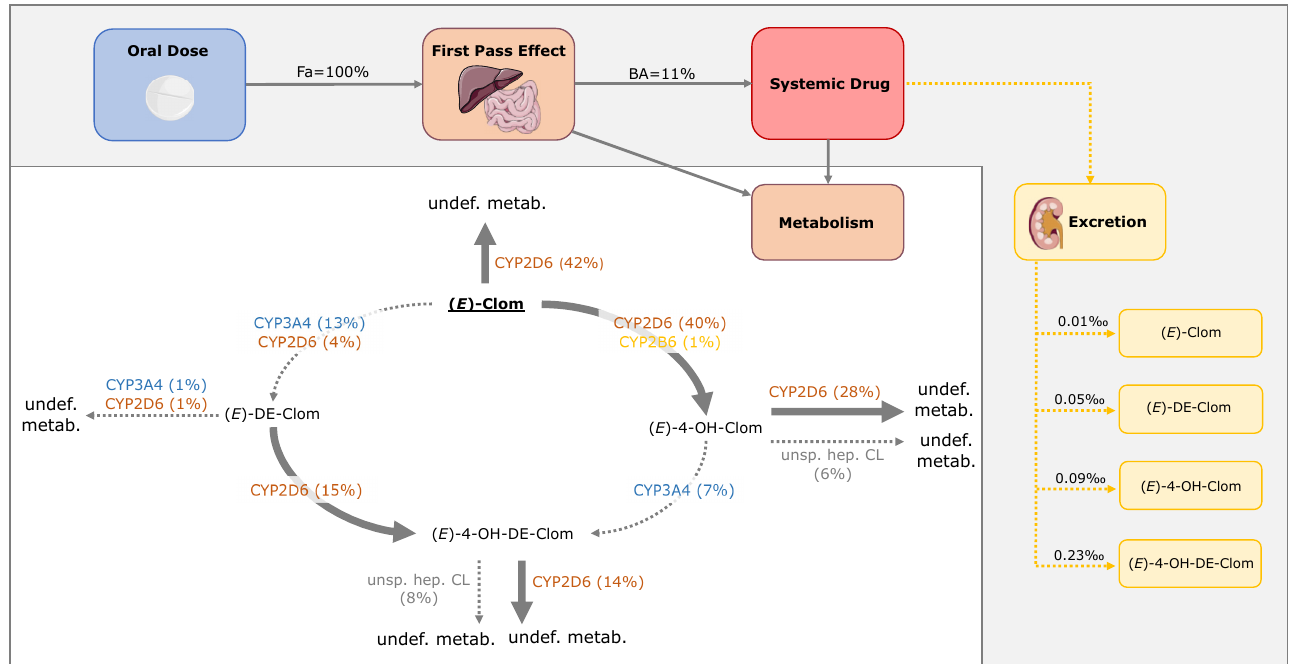
black lines mark the lines of identity; the curved black lines show the limits of the predic- tive measure proposed by Guest et al. with 1.25-fold variability [32]. Black dotted lines in- dicate 1.25-fold; black dashed lines indicate two-fold deviation. AS, CYP2D6 activity score;